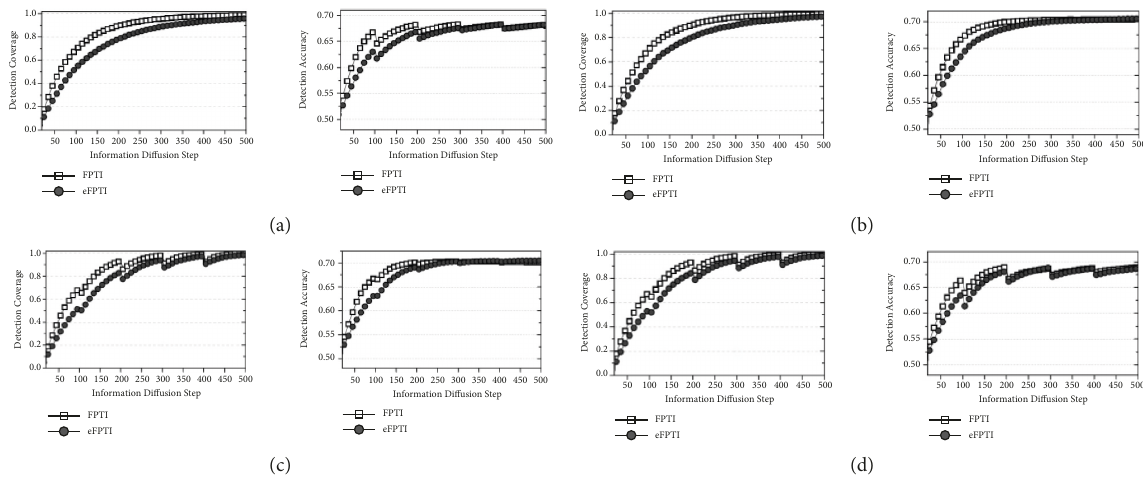
Figure 11: The robustness tests of the FPTI and eFPTI models in different types of dynamic environments. (a) Agent behavior pattern reset. (b) Network relationship rewiring. (c) New agent entrance. (d) Mixed dynamic